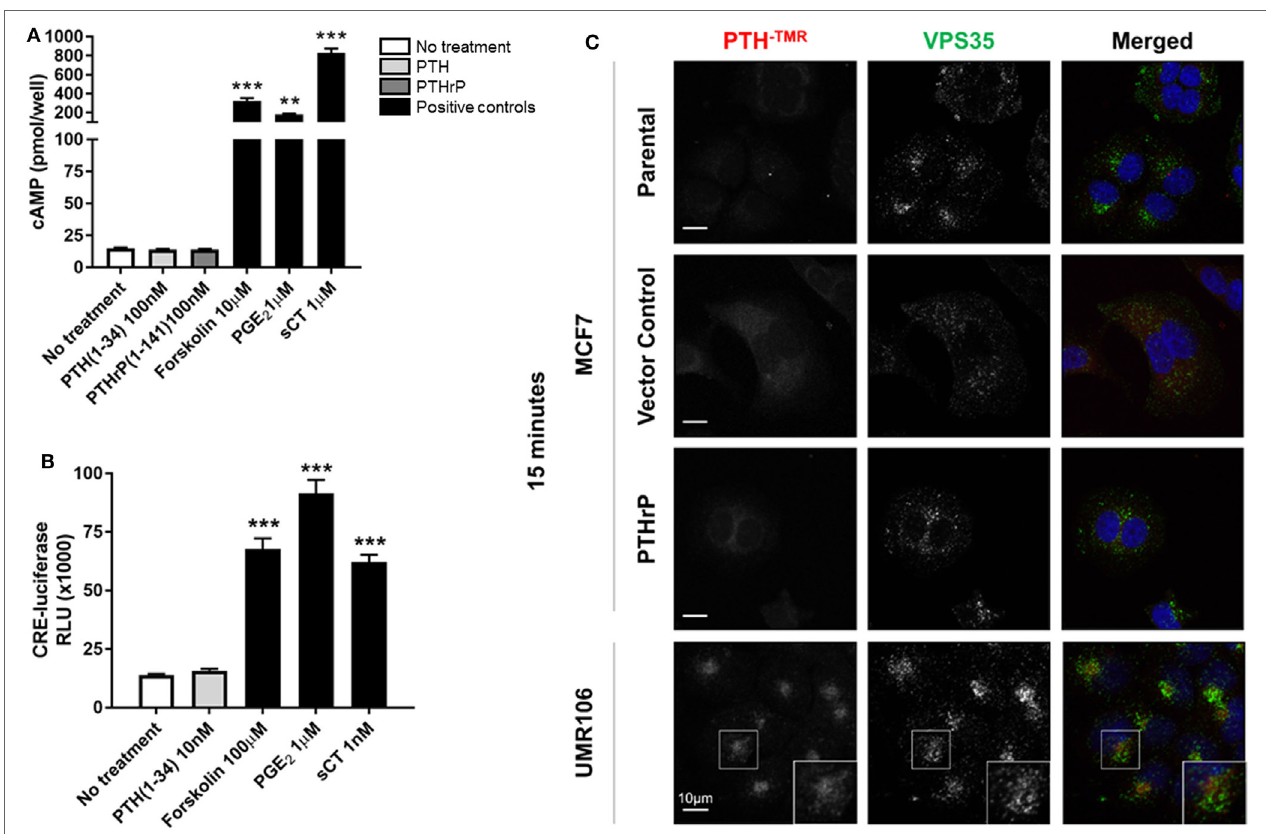
FigUre 2 | Neither parathyroid hormone (PTH) nor parathyroid hormone-related protein (PTHrP) bind to/activate cyclic AMP (cAMP) in MCF7 cells. (a) cAMP production in MCF7 cells following 12 min stimulation with PTH(1–34) or PTHrP(1–141), or positive controls forskolin, prostaglandin E 2 (PGE 2 ), or salmon calcitonin (sCT). Graphs = mean + SE. n = 3 replicates from independent experiments. ** p < 0.01, *** p < 0.001 vs no treatment by one-way ANOVA with multiple comparisons. (B) cAMP response element (CRE)-luciferase signal following 4 h stimulation with PTH or positive controls forskolin, prostaglandin E 2 (PGE 2 ), or sCT. Graphs = mean + SE. n = 3 replicates from independent experiments. *** p < 0.001 vs no treatment by one-way ANOVA with multiple comparisons. (c) Confocal images of stable MCF7 and UMR106-01 cells cultured on poly- l -lysine-coated glass coverslips and serum starved for 1 h prior to the addition of tetramethylrhodamine-labeled PTH(1–34) (PTH -TMR , 100 nM) for 15 min at 37°C. Cells were fixed in 4% PFA and immunostained for the endogenous retromer subunit, vacuolar protein sorting 35 (VPS35). Scale bar, 10 µm. Representative of n = 3 independent